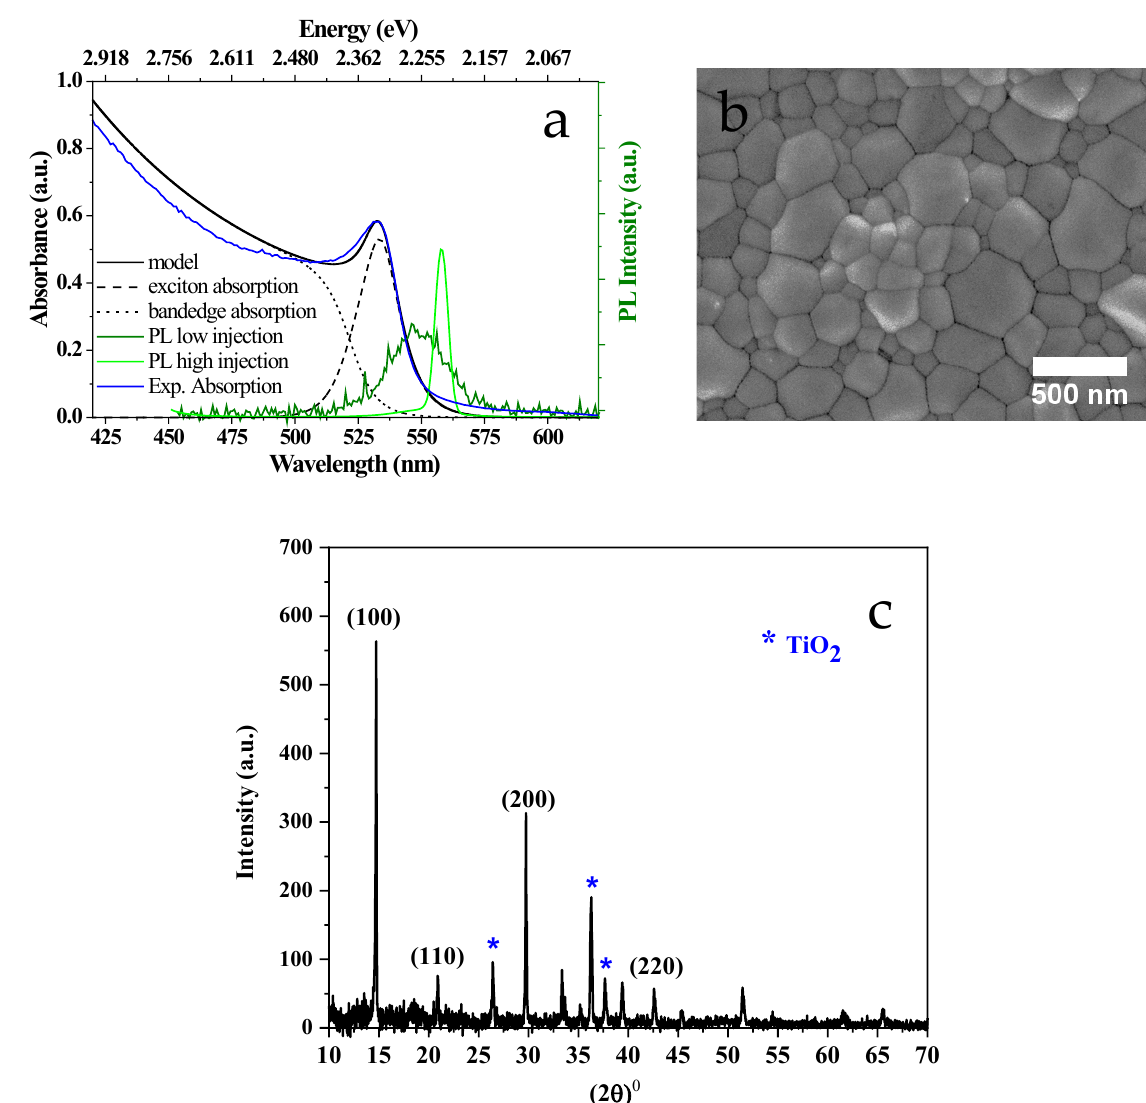
Figure 1. ( a ) The FAPbBr 3 film’s absorbance and PL spectra. In the black line, the computed bandgap and exciton absorption spectra, as well as their summed spectrum, are depicted. For comparison, two PL spectra at low and high pump energy densities are given in green. The Two PL spectra are not to scale. ( b ) The FAPbBr 3 film’s plan view SEM image, and ( c ) the XRD pattern of the FAPbBr 3 film deposited onto mesoporous TiO 2 .